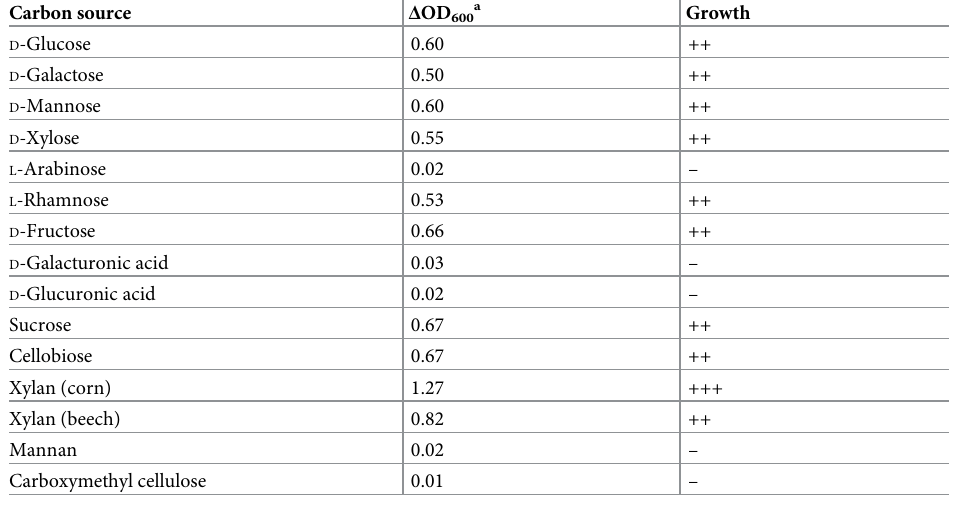
Table 4. Growth of Scheffersomyces insectosa (strain: Fo1-1-1), the yeast symbiont of Leptura ochraceofasciata on different carbon sources. Carbon source Δ OD 600a Growth D -Glucose 0.60 ++ 0.50